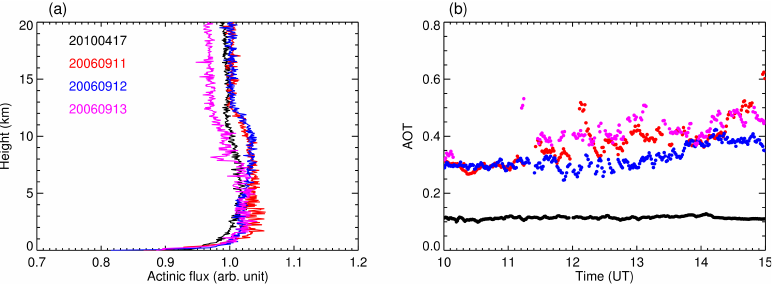
Figure 4. (a) Clear-sky actinic flux profiles measured on 11–13 September 2006 and 17 April 2010. (b) AOT at 501nm measured in Cabauw for the same days. The profiles are the original measurements, not normalized.